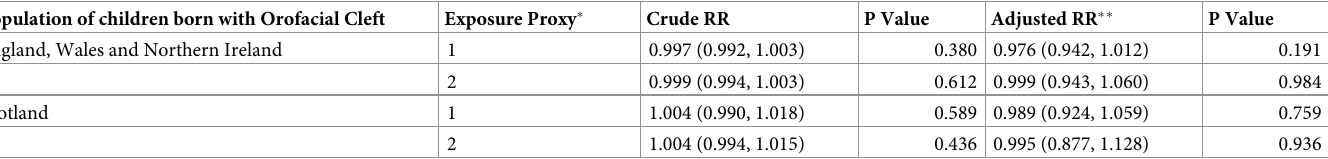
Table 1. Crude and adjusted association (Incidence rate ratio: RR) of the annual prevalence of active smoking (%), based on the two proxy measures � , with the inci- dence of orofacial cleft. Population of children born with Orofacial